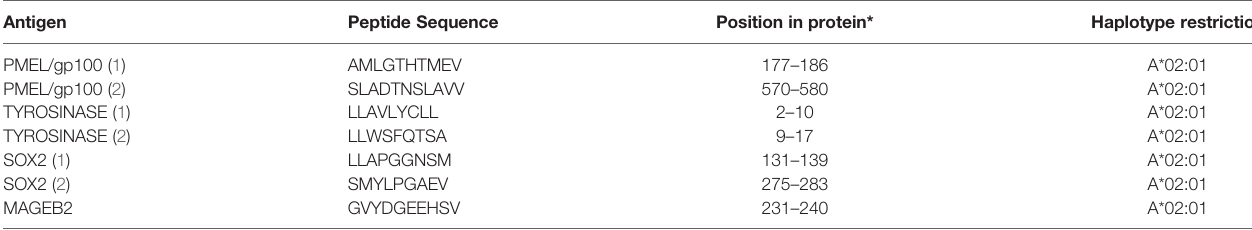
TABLE 1 | Peptides tested in ELISPOT assay for Patient#5. Antigen Peptide Sequence